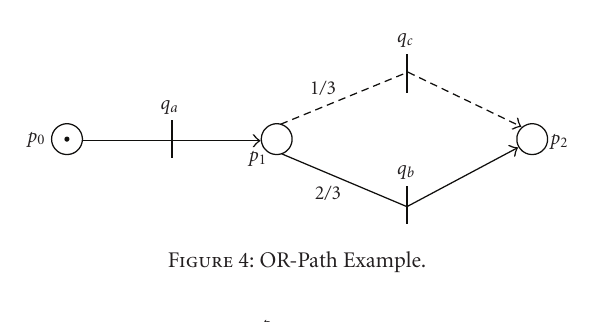
Figure 4: OR-Path Example.